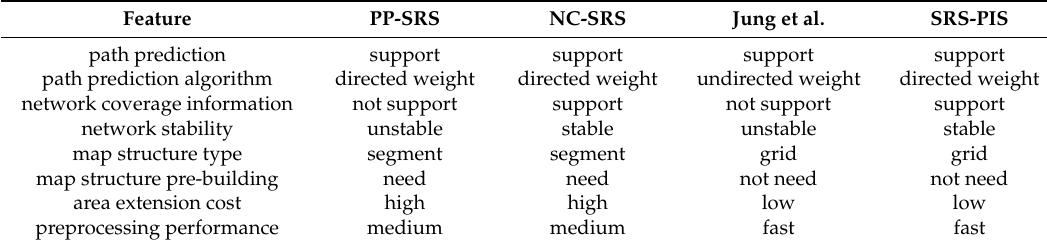
Table 2. PP-SRS, NC-SRS, Jung et al.’s system and SRS-PIS.